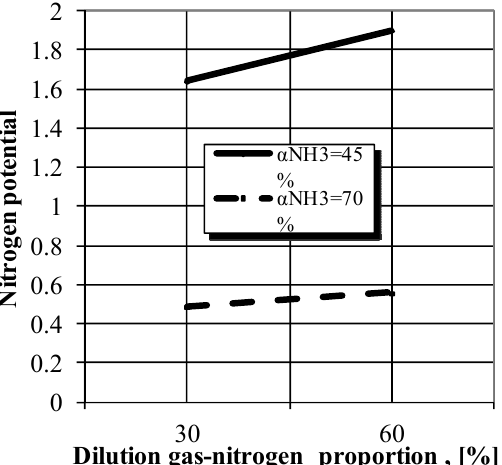
Figure 2. The N potential variation in the NH 3 + N 2 gaseous mixture used for nitriding, depending on the NH 3 dissociation degree (45% and 70%) and the gas-nitrogen dilution proportion.